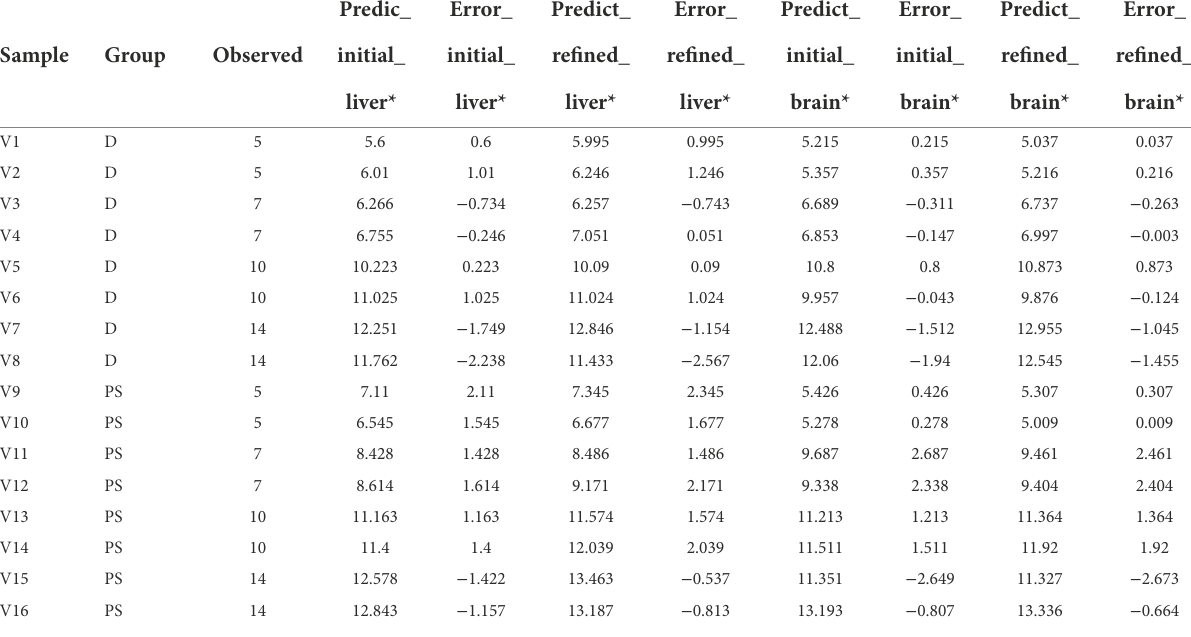
TABLE 2 Prediction results of validation samples derived from the initial and refined regression models.